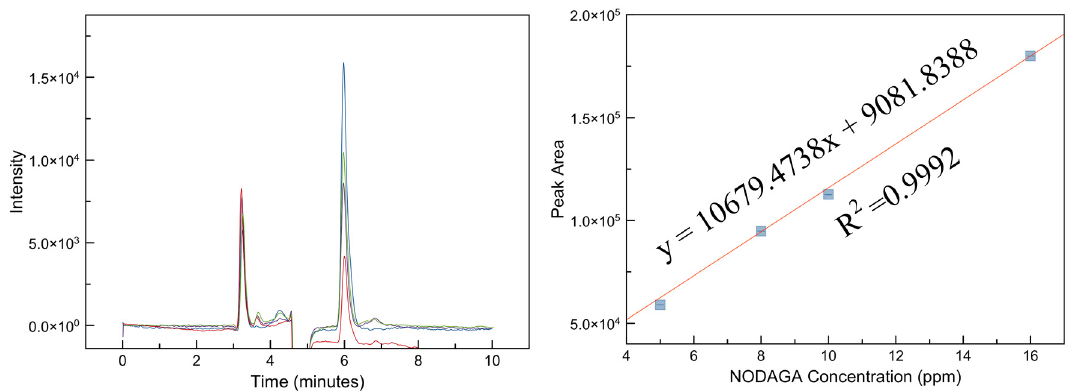
Figure 7. Linearity overlaid chromatograms and calibration curve for the unreacted NODAGA chelator; R 2 = 0.9992, y = 10679.4738x + 9081.8388.